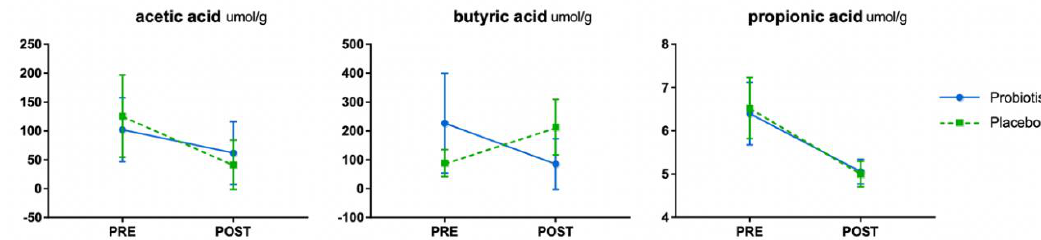
Figure 3. Short-chain fatty acids (SCFA) analysis. No significant difference was observed in acetic acid level before and after probiotics intake; however, both the intake and the control groups demonstrated a significant decrease over time. However, a difference in the level of butyric acid was observed before intake in the two groups. No significant difference was observed in the level of propionic acid, before or after consumption of probiotics.